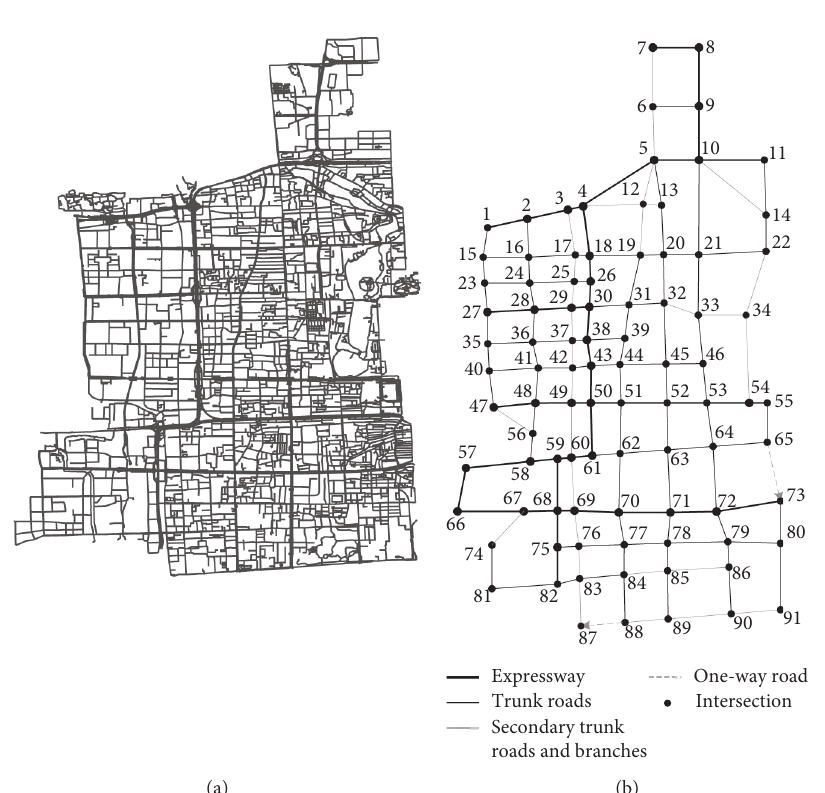
Figure 5: Network topology construction of Xicheng District. (a) Roadway map of Xicheng District. (b) Network topology of Xicheng